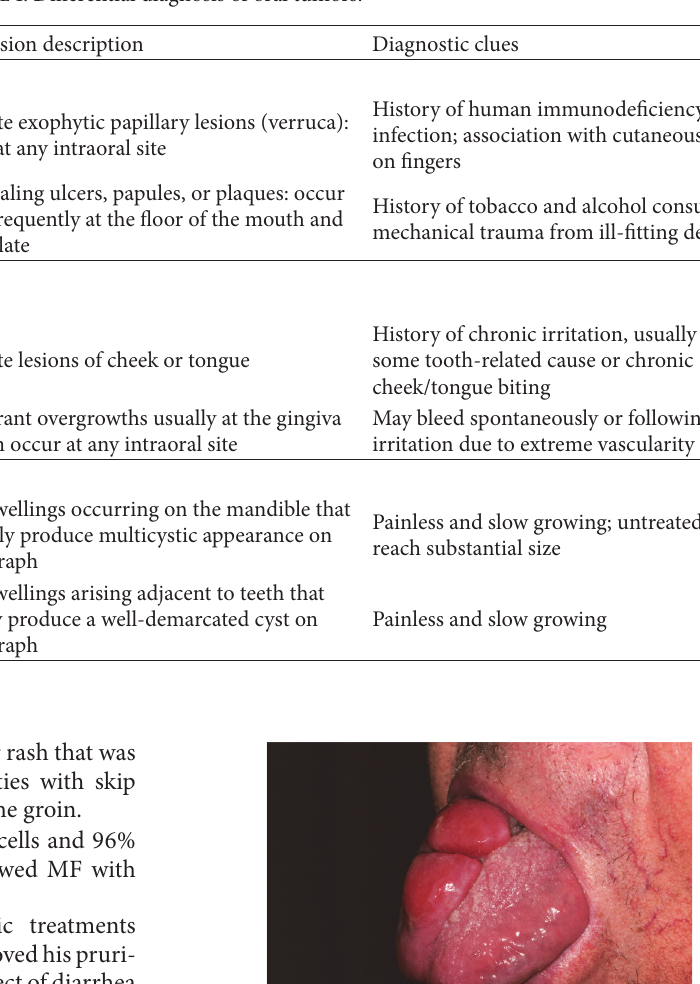
Table 1: Differential diagnosis of oral tumors.